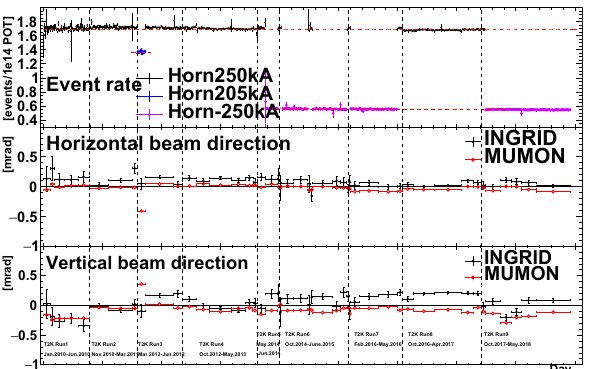
Fig. 53 The event rate at INGRID as a function of the beam time is shown (top plot). The horizontal and vertical neutrino beam directions monitored by MUMON and INGRID are shown in the middle and bottom plots